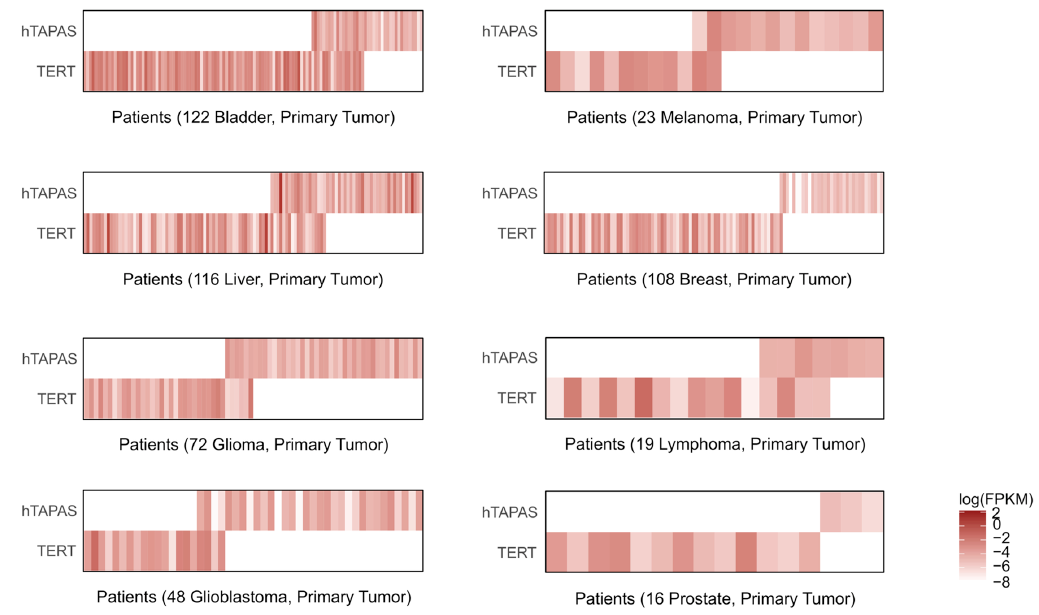
Figure 3. hTERT and hTAPAS expression are inversely correlated in primary tumors. RNA ‐ seq data samples from TCGA, which have detectable expression levels for either hTERT or hTAPAS were analyzed in the eight different cancers (melanomas, gliomas, glioblastomas, hepatocellular carcinomas, bladder, lymphoma, prostate and breast cancers). A majority of these tumor samples express either hTERT or hTAPAS , but not both. The heat ‐ maps depict corresponding expression levels of hTAPAS and hTERT among individual patient samples from the eight different cancers. Expression is represented as log ‐ transformed Fragments Per Kilobase of transcript per Million mapped reads (FPKM) values (white indicates undetectable expression).